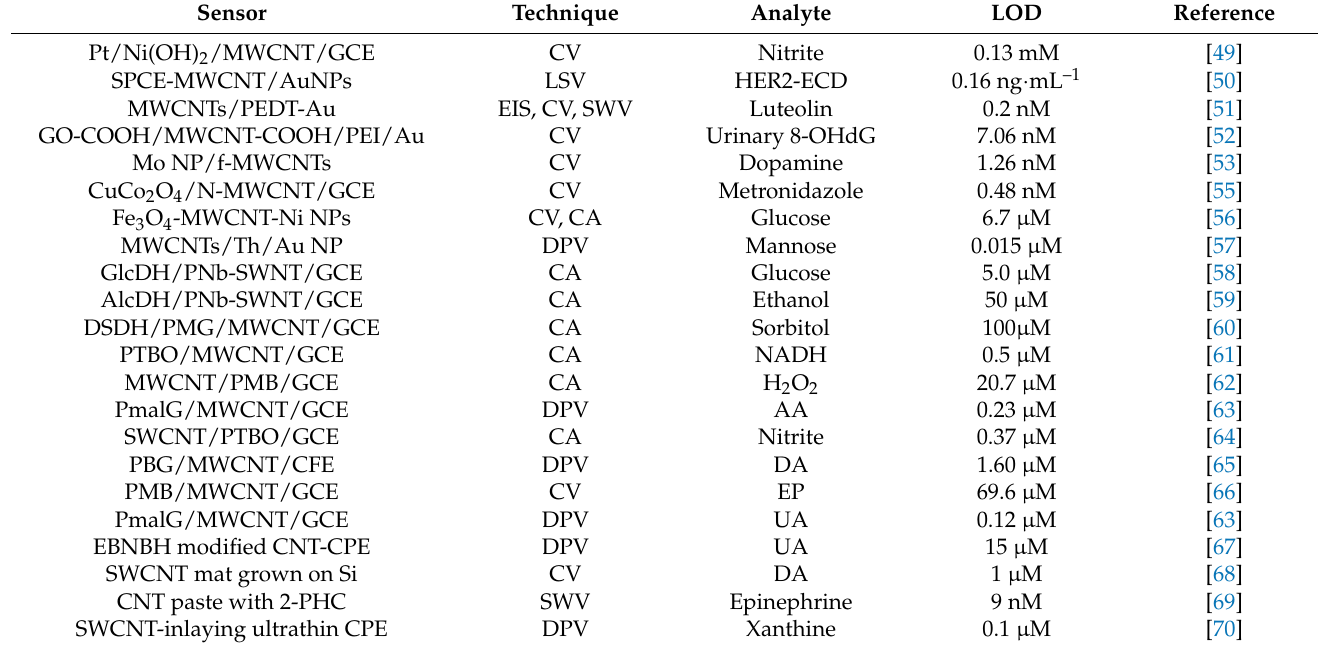
Table 1. Detectable bioanalytes using carbon nanotube